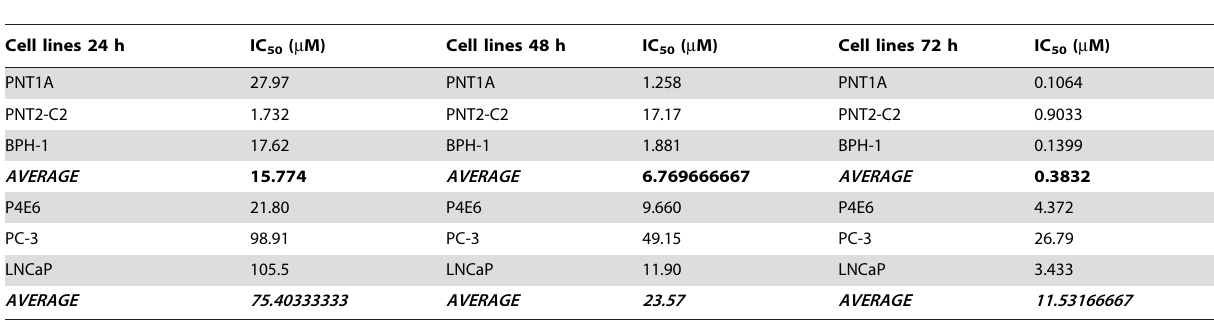
Table 3. IC 50 values of the Pd complex in cell